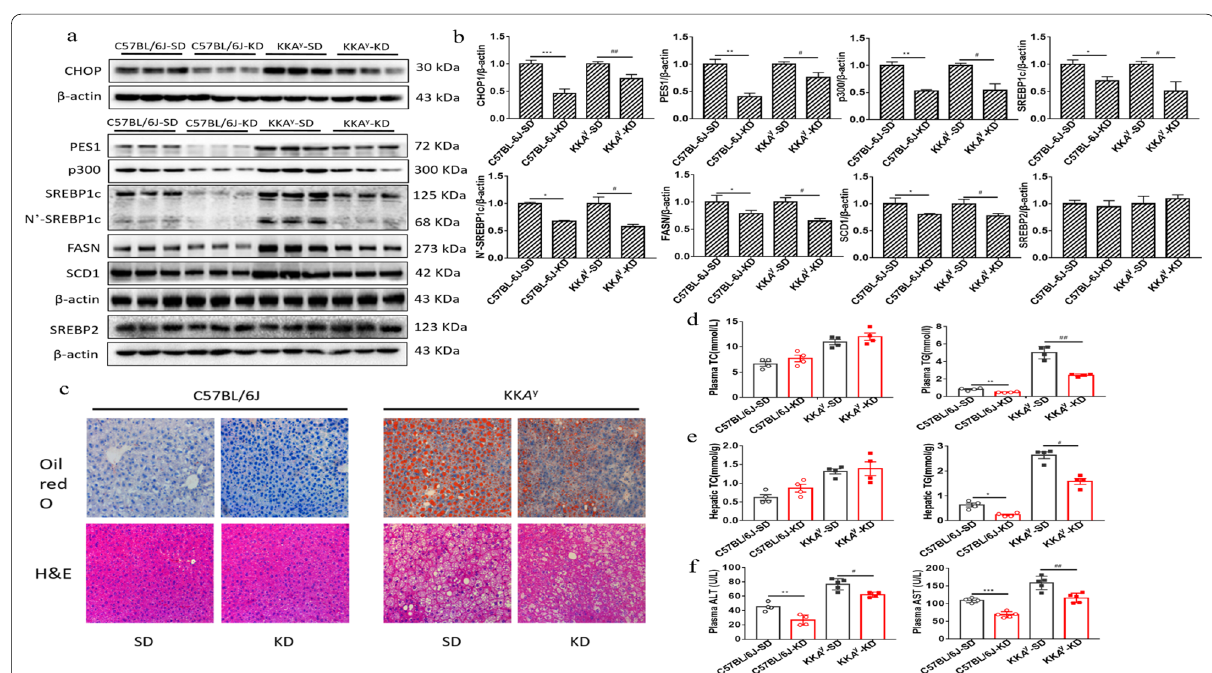
Fig. 2 KD suppressed the PES1 expression and decreased plasma and hepatic TG levels in normal and diabetic mice. a , b The protein levels of hepatic CHOP, PES1, p300, SREBP1c, SREBP2, FASN and SCD1 were detected by Immunoblotting. c The oil red O and H&E staining of liver tissues were performed for different groups, original magnification, 10. Scale bar, 50 μm. d Plasma TG and TC were assayed for different groups by the end × of food feeding. e Hepatic TG and TC levels were detected for different groups. f Plasma AST and ALT levels were measured by Reagent kit. Values are means SEM for each experiment performed independently 3 times. SD (Standard diet), KD (Ketogenic diet). *P < 0.05, **P < 0.01, ***P < 0.001 ± compared with control for C57BL/6J, # P < 0.05, ## P < 0.01, ### P < 0.001 compared with control for KK A y (ANOVA, Student–Newman–Keuls q